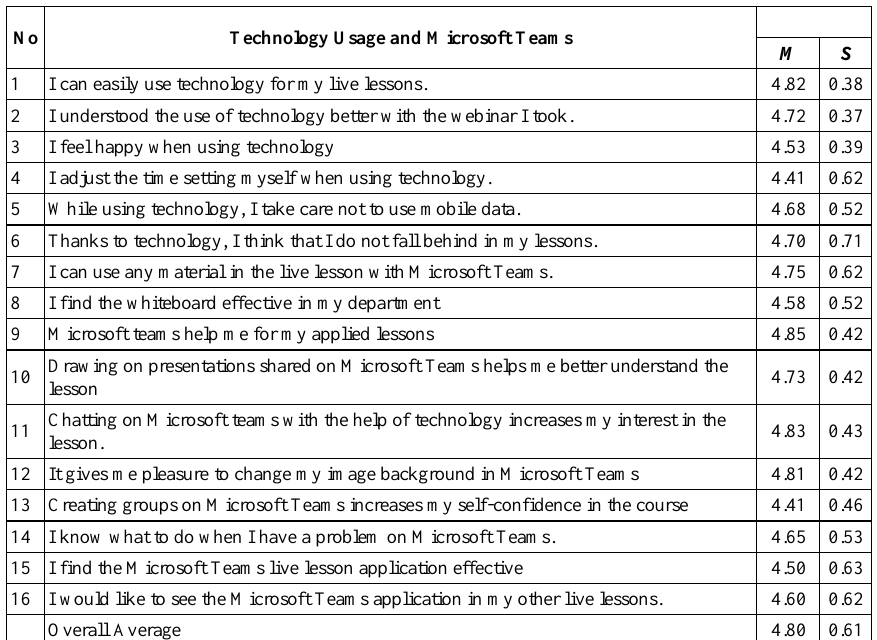
Table 5. Distance education views of university